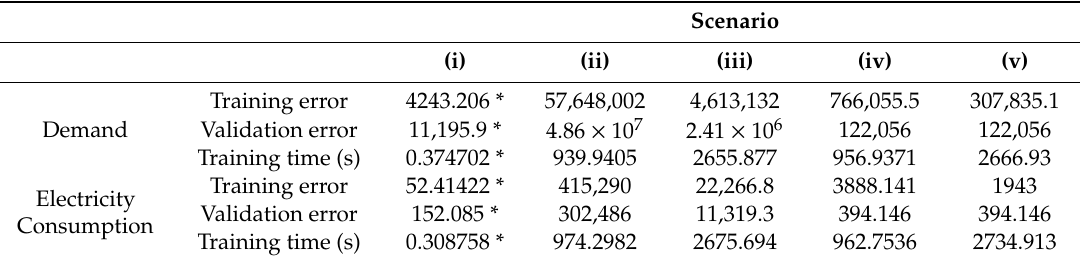
Table 8. Result summary of the sensitivity analysis in the MRTM-guided